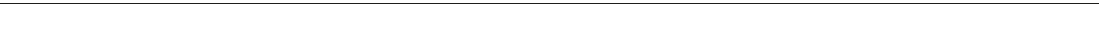
Immunoprecipitation with anti-Cx26 antibody was performed in MDA-MB-231 CSCs and b non-CSCs transduced with either empty vector or Cx26 overexpression vector. The precipitates were probed for pFAK (Y397), total FAK, NANOG, and Cx26 by immunoblotting. c Immunoblots of the cell